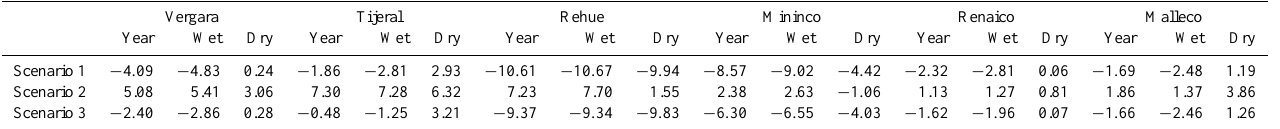
Table 13. Percentage of change respect to the baseline scenario for mean annual, wet season (May–October) and dry season (November– April)